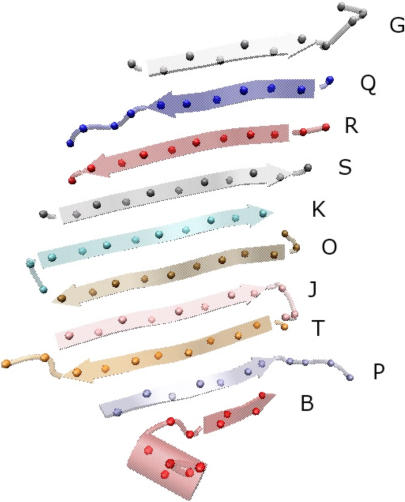
Example of Calculation of the Residue-Specific Local OrderAn example of an ordered oligomer with Nc = 10 for 20 Aβ25–35 peptides after 109 Monte Carlo steps. The spheres on each peptide chain stand for Cα atoms. The βi,j values of each peptide chain are given as G(01111110000), Q(00111111110), R(01111111111), S(01111111110), K(00111111111), O(00111111111), J(01111111000), T(01111110000), P(01111111000), and B(00000000100). The two different ways of averaging the β sheet parameter (β and βo) are calculated as β = 111/220 where 111 is the total number of ordered residues in the ensemble of 20 peptides and 220 is the total number of residues (20 × 11), and βo = 72/110 where 72 is the number of ordered residues in the oligomer shown above and 110 the total number of residues within this particular oligomer (10 × 11).